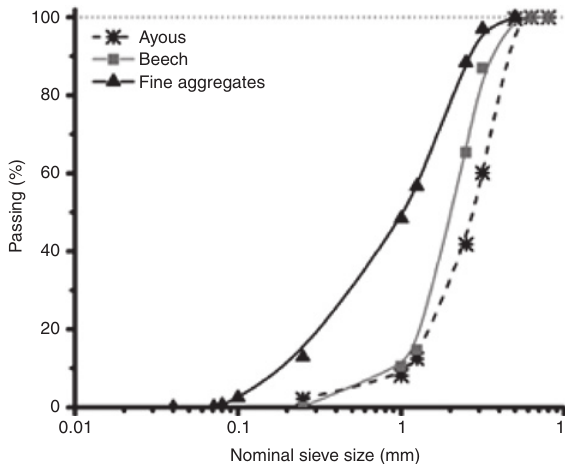
Figure 3: Results of sieve